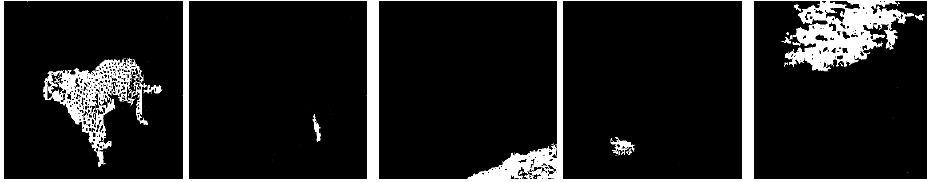
Figure 28. Objects extracted by the proposed approach.